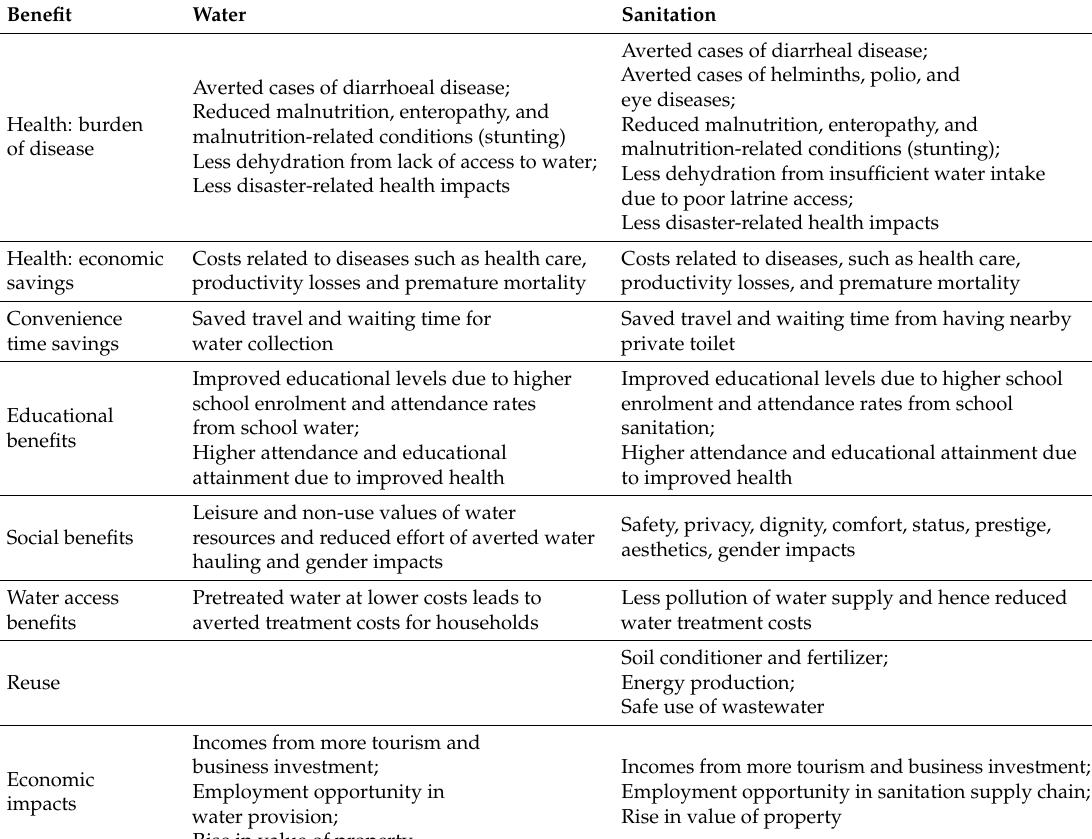
Table 6. Benefits of improved drinking water supply and